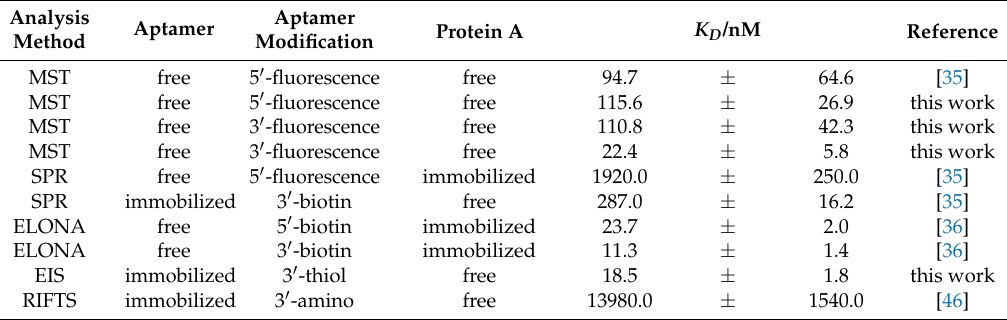
Table 2. Apparent dissociation constant, K D , determined with different analysis methods for the ELONA = enzyme-linked oligonucleotide assay, EIS = electrochemical impedance spectroscopy, RIFTS = reflective interferometric Fourier transform